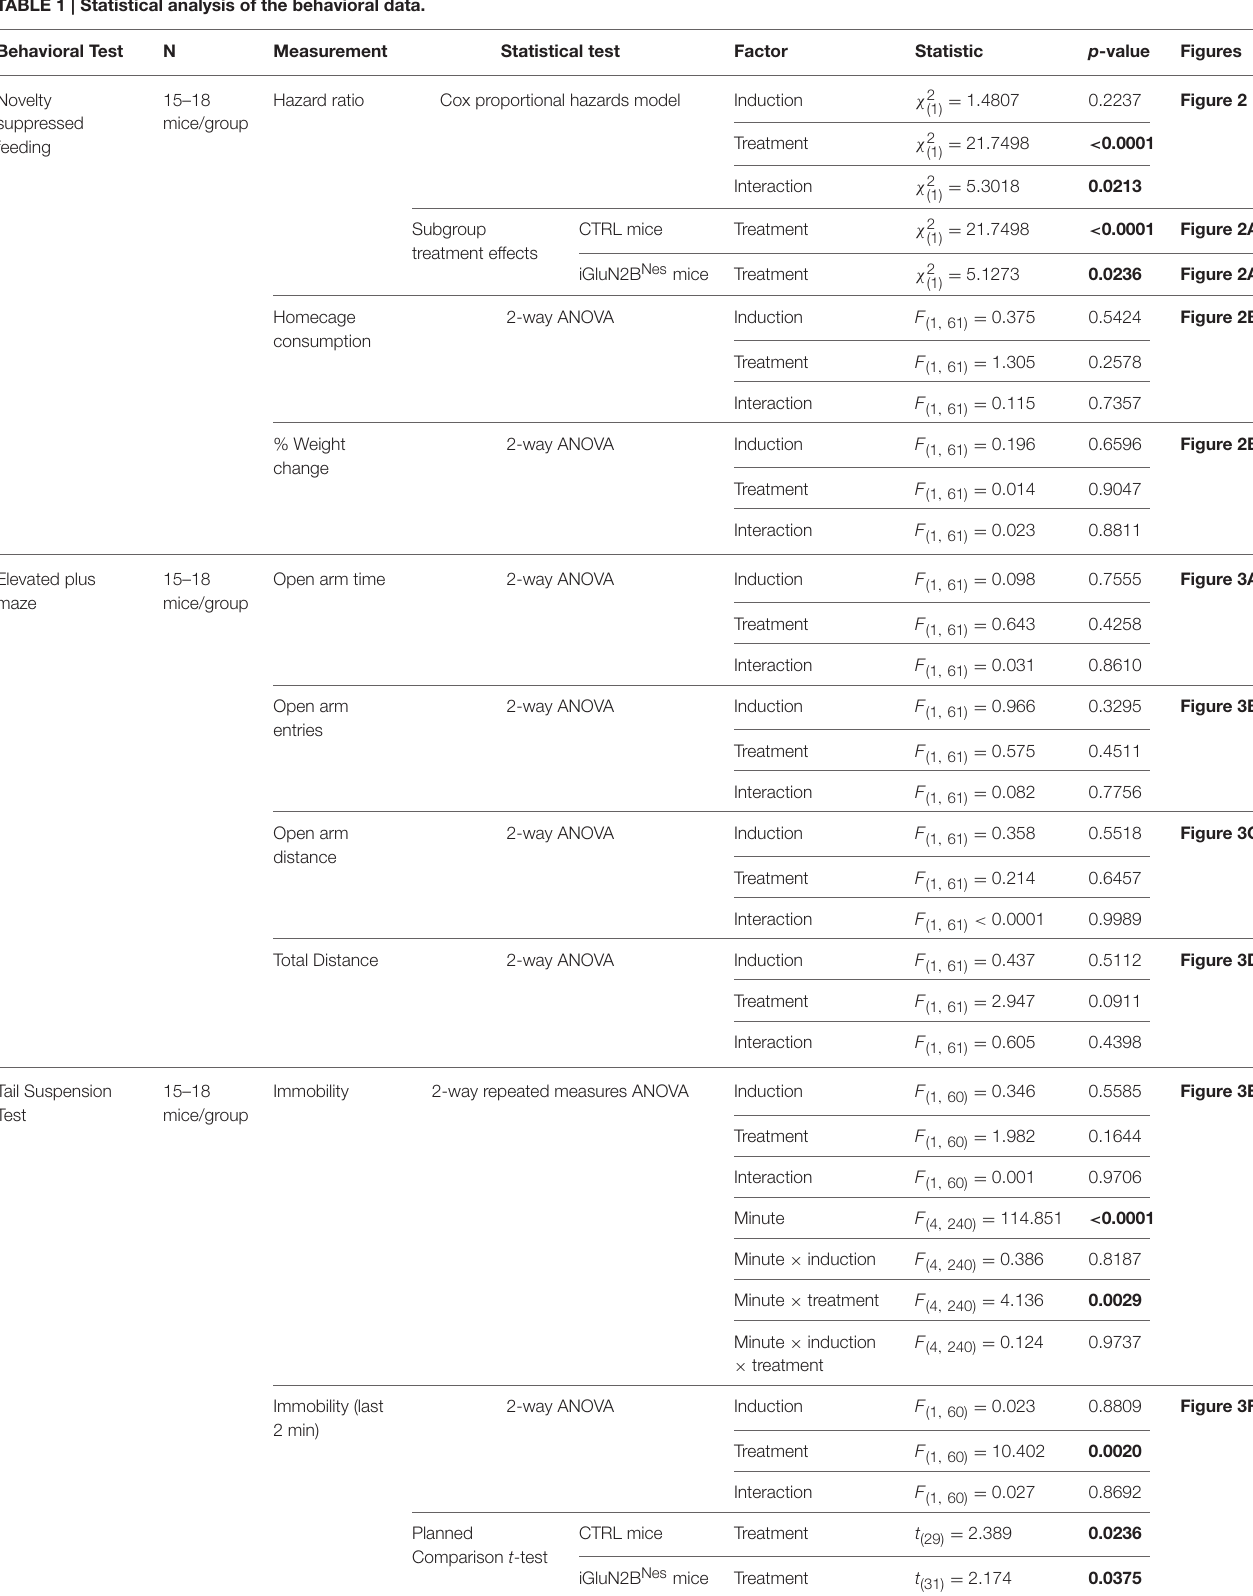
TABLE 1 | Statistical analysis of the behavioral